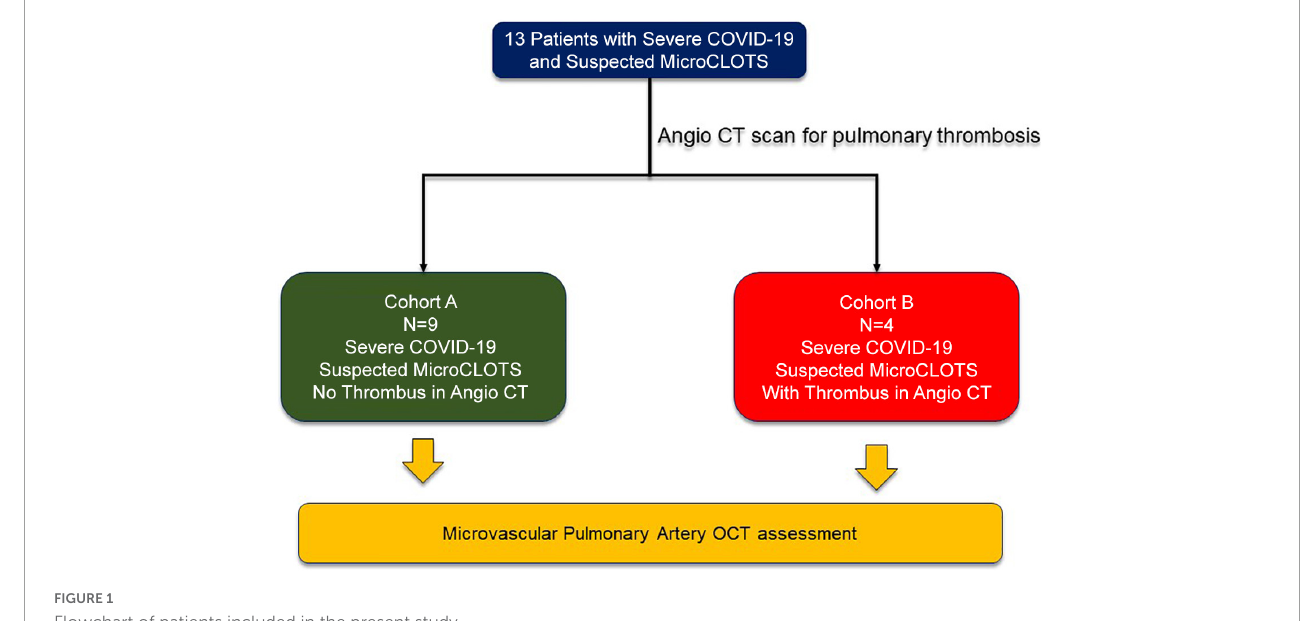
FIGURE1 Flowchart of patients included in the present study.